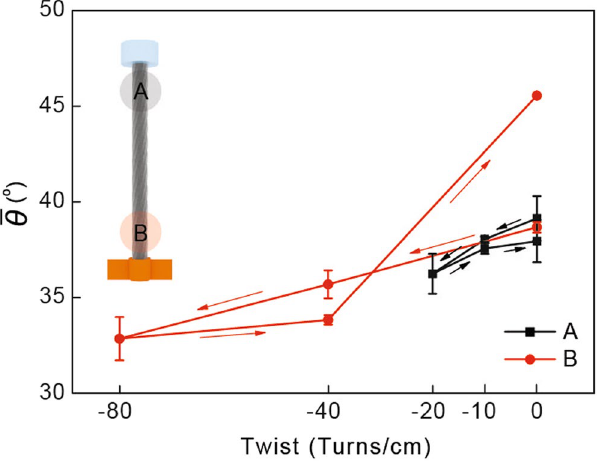
Figure 5. Change in average orientation angle of one-ended tethered yarn during torsional test. Arrows indicate untwisting and retwisting operations. Legends A and B indicate the measurement regions as shown in the inset figure.